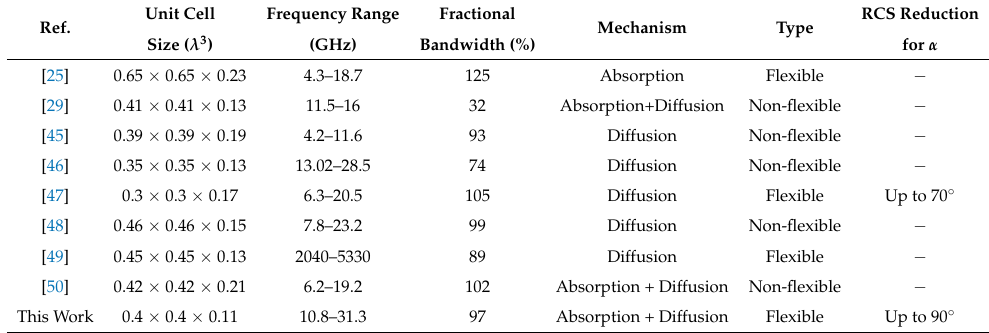
Table 1. Comparison with state-of-the-art reported work.